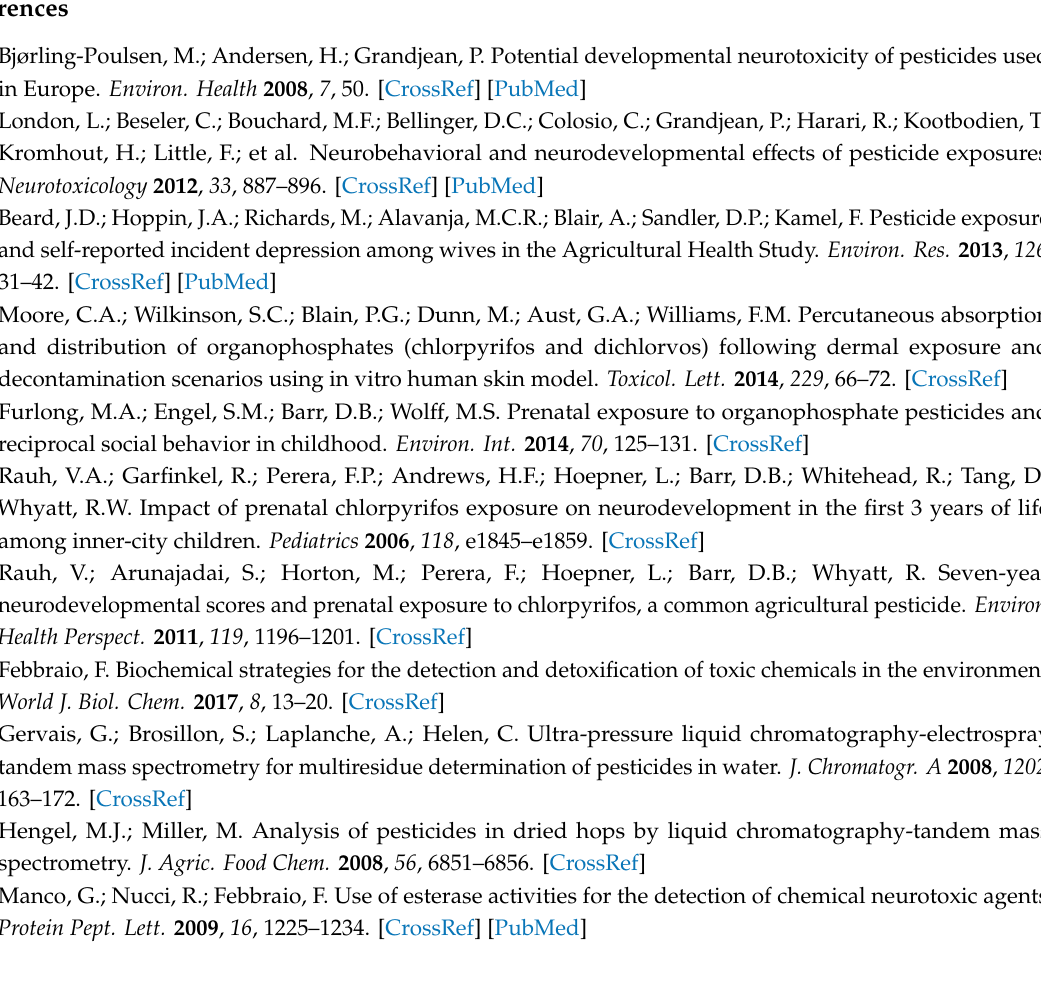
Table S1: MRM Transitions and Mass Spectrometry Settings; Figure S1: Plot of EST2 residual activity in presence of increasing NBS concentrations; Figure S2: Calibration curve of fluorescence intensity at increasing concentrations of 4-MU in HEPES bu ff er, measured using the robotic workstation; Figure S3: Calibration curve of inhibitory activity at increasing concentration levels of Paraoxon in HEPES bu ff er in presence of enzyme, measured using the robotic